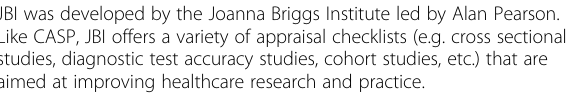
Table 7 JBI (Joanna Briggs Institute-tool)